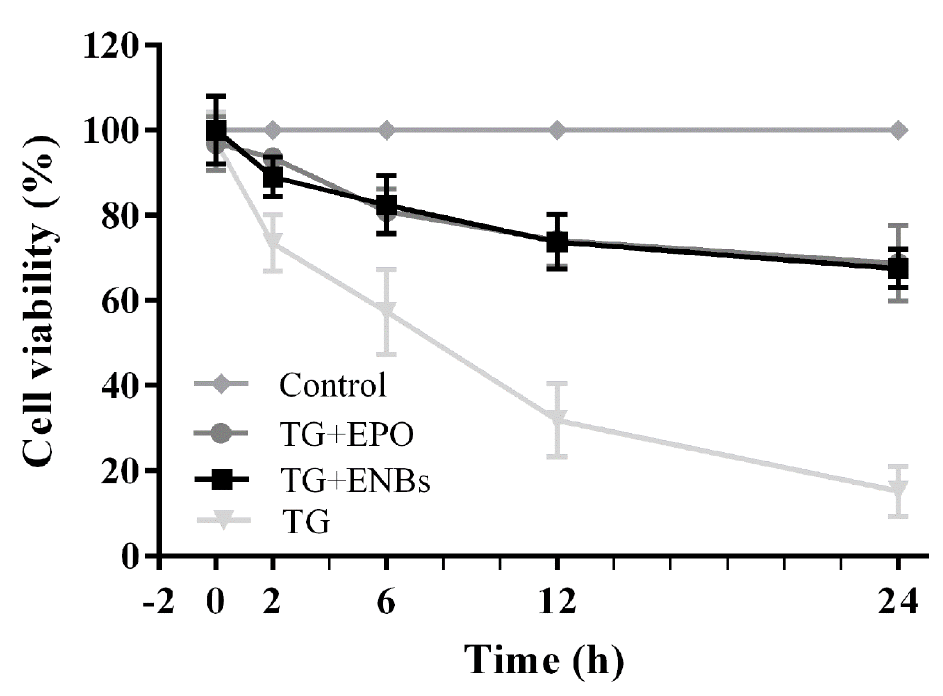
Figure 3. Viabilites of SH-SY5Y neuronal cells over 24 h. An MTS asssy was conducted. The control group was the cell-only group. The data are shown as the mean ± SD (error bars).